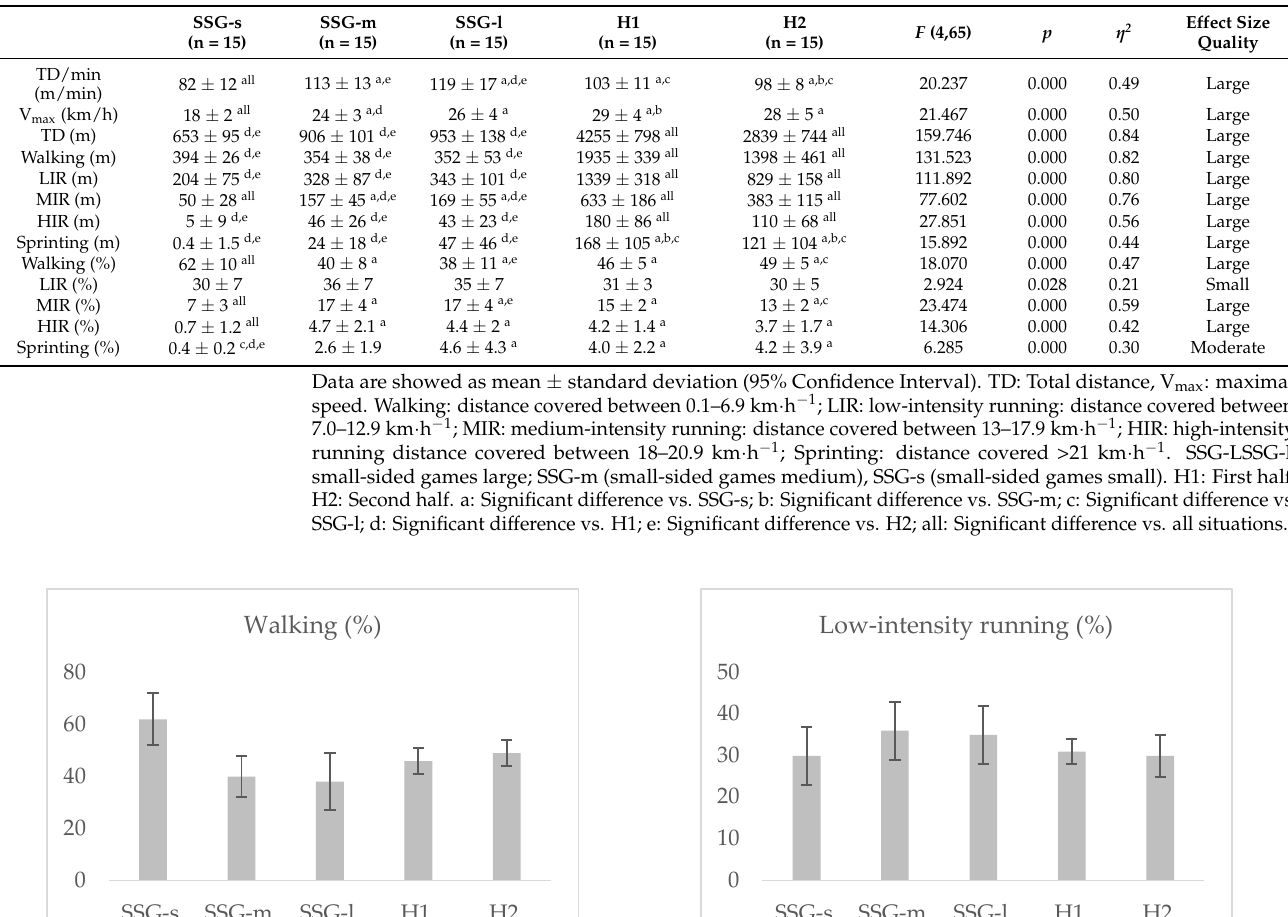
Table 3. One-way ANOVA of the physical responses on soccer players in different SSG and competi- tion match.